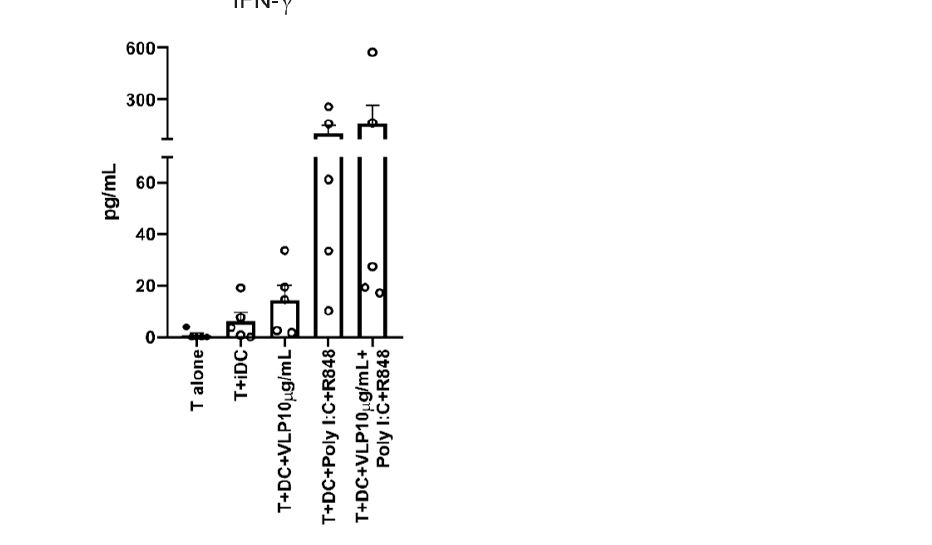
Figure 6. T cells release IFN- γ into the medium. Five days after the co-culture of T cells with stimulated DCs (100,000:10,000), the medium was collected, and the ELISA was performed. Each column represents the mean ± SEM of five independent experiments (each point corresponds to an individual donor). No statistically significant differences were found in any parameter analysed.